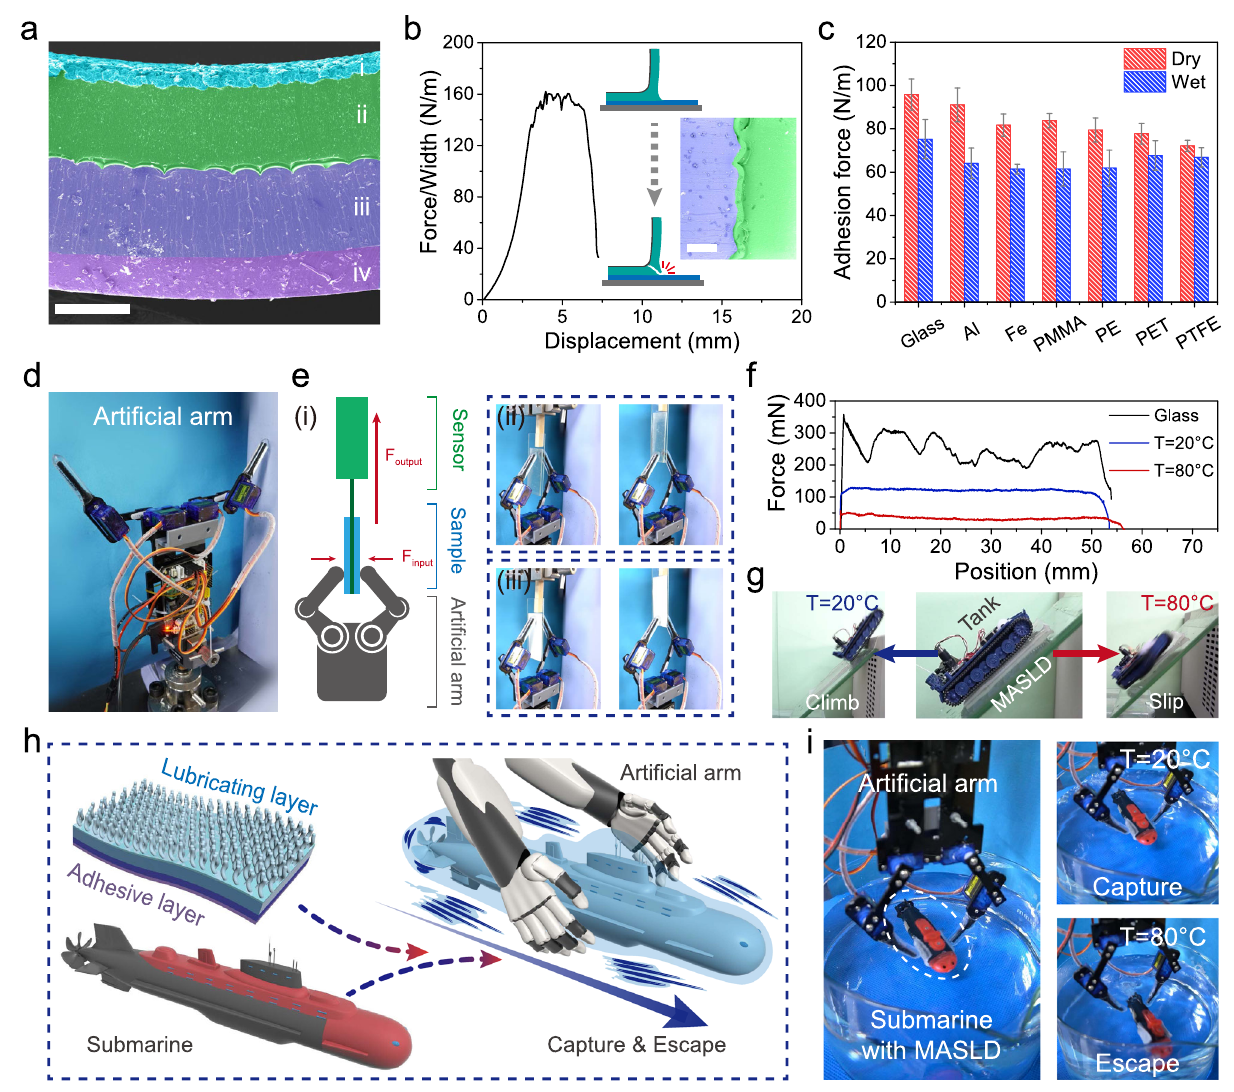
Fig. 6 Adhesion, lubrication performance, and demonstration of MASLD. a The cross-section SEM morphology of MASLD including lubricating layer (blue, i), phase-separation hydrogel matrix (green, ii), highly cross-linked PDMS layer (indigo blue, iii) and lightly cross-linked PDMS layer (purple, iv), scale bar: 500 μ m. b The 90° peeling test for evaluating the interface bonding strength between the PDMS and hydrogel matrix, and the fracture diagram during test. The insert was enlarged SEM image of interface, scale bar: 300 μ m. c Adhesion behavior of MASLD for different substrates, the data were presented as mean ± SD and sample size n = 3. d Arti fi cial arms used in force testing and capture system. e Schematic diagram to demonstrate the testing process for responsive lubrication behavior of MASLD by applying arti fi cially mechanical arms (e-i). Two pieces of MASLD patches were attached onto each side of the glass sheet, which was linked with a force sensor, and then interface friction force signals can be captured by pulling at 20 °C (e-ii) and 80 °C (e-iii). PDMS-decorated mechanical arms were used as loading systems. f Force signals in pulling process between the samples and arms. g Controllable movement of a mobile device on a MASLD-decorated tilted glass plate in response to temperature. h , i Schematic diagram and demonstration of the underwater mechanical system to in-situ capture device with MASLD, and the device escaped like fi Preparation of gradient cross-linked PDMS . Different ratios of the PDMS and curing agent (10:1, 20:1, 30:1,40:1, 50:1) were well mixed in a plastic cup and vacuumed in a vacuum pump for 20 min to remove air bubbles. Non-gradient cross-linked PDMS was cured at 80 °C for 4 h to make it cured. For gradient cross- linked PDMS (50-20:1), PDMS (20:1) was cured at 80 °C for 15min to make it partially cured. Then, the lightly cross-linked PDMS precursor (50:1) was poured on top of the precured 20:1 PDMS, and the two components were subsequently cured at 80°C for 4 h to make them completely joined together through an interfacial hydrosilylation reaction.